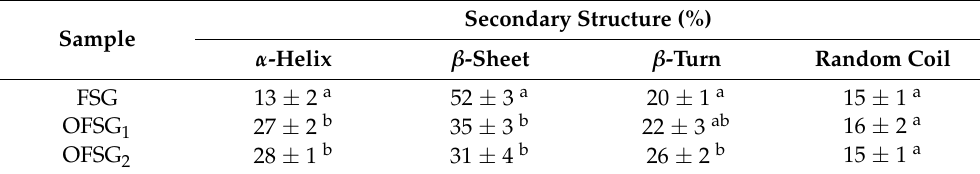
Figure 2. Fourier-transform infrared spectroscopy (FTIR, ( A , D )), X-ray diffraction (XRD, ( B , E )) and nuclear magnetic resonance (NMR, ( C , F )) spectra of fish scale gelatin and octenylsuccinate fish scale gelatin (OFSG 1 , degree of substitution = 0.026; OFSG 2 , degree of substitution = 0.107) with or without the loading of curcumin. Table 1. Percent contribution of the secondary structure of fish scale gelatin (FSG) and octenylsuccinate fish scale gelatin (OFSG). Values of samples bearing different superscript lowercase letters (a, ab, and b) within the same secondary structure are significantly different ( p < 0.05).